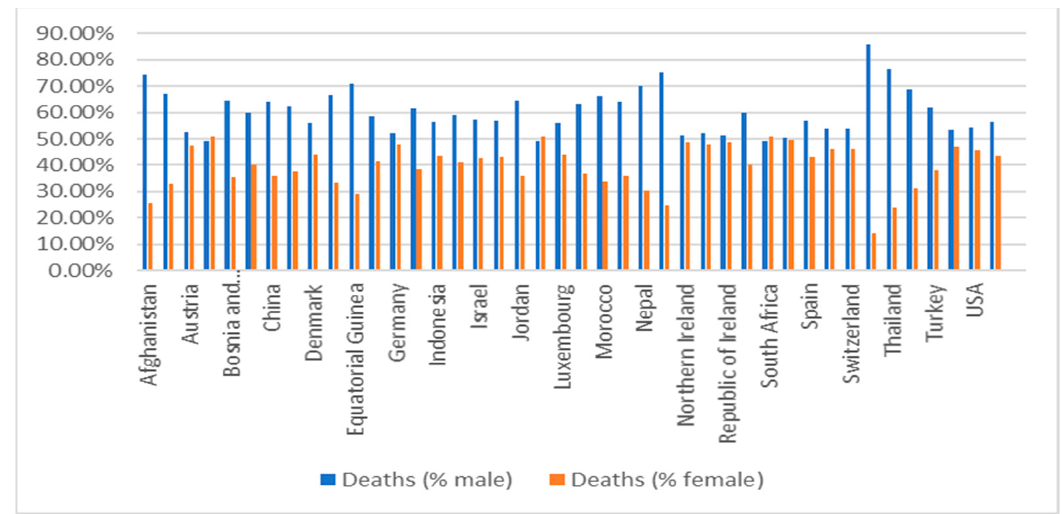
Figure A1. Distribution of infected people in terms of gender (male, female) among various coun- tries.